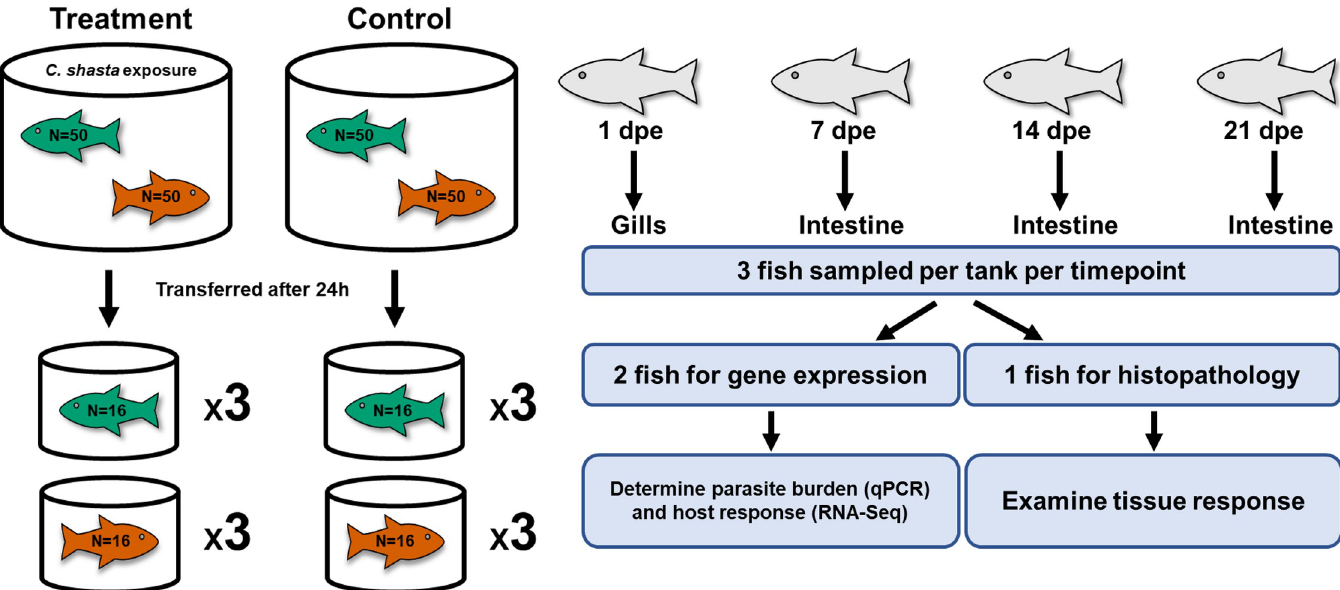
Fig 1. Experimental diagram of the exposure conditions and subsequent sampling of steelhead. Susceptible steelhead (green) and resistant steelhead (orange) were exposed to Ceratonova shasta for 24 hours and then each phenotype was separated and placed into triplicate tanks. Resistant fish had been previously fin-clipped as a means of identification. dpe = days post